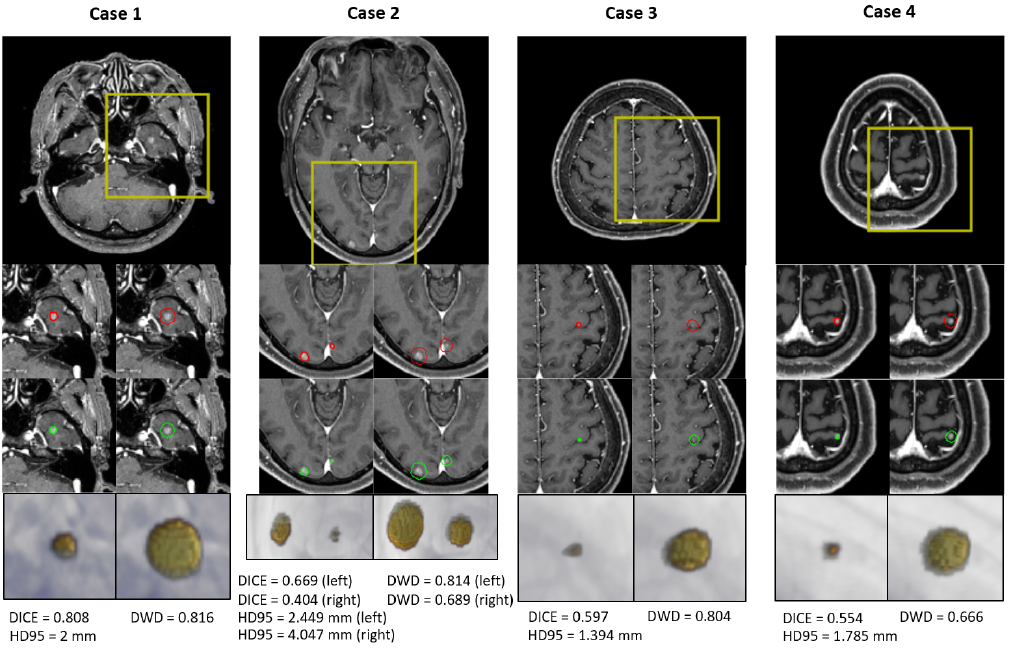
Figure 5. Examples of the ground-truth delineation and predicted delineation. The yellow bounding box in the first row indicates the area where false positives occurred. The second row shows the manual delineation of the tumor volume and the manual delineation dilated to 3 mm. The third row shows the predicted delineation from DL and the predicted delineation dilated to 3 mm. For the second and the third rows, red and green indicate manual and predicted delineation, respectively. The last row shows the 3D rendering overlapped with manual delineation and predicted delineation, and 3D rendering dilated to 3 mm each. In the last row, renderingRendering in red is predicted delineation and rendering in yellow is manual